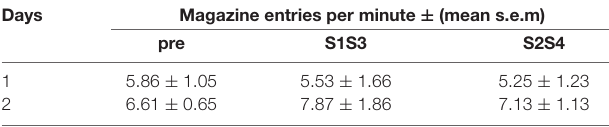
TABLE 1 | Appetitive training data for Experiment 1—Magazine entries per minute (mean ± s.e.m) in the absence (pre) or presence of the two compounds S1S3 and